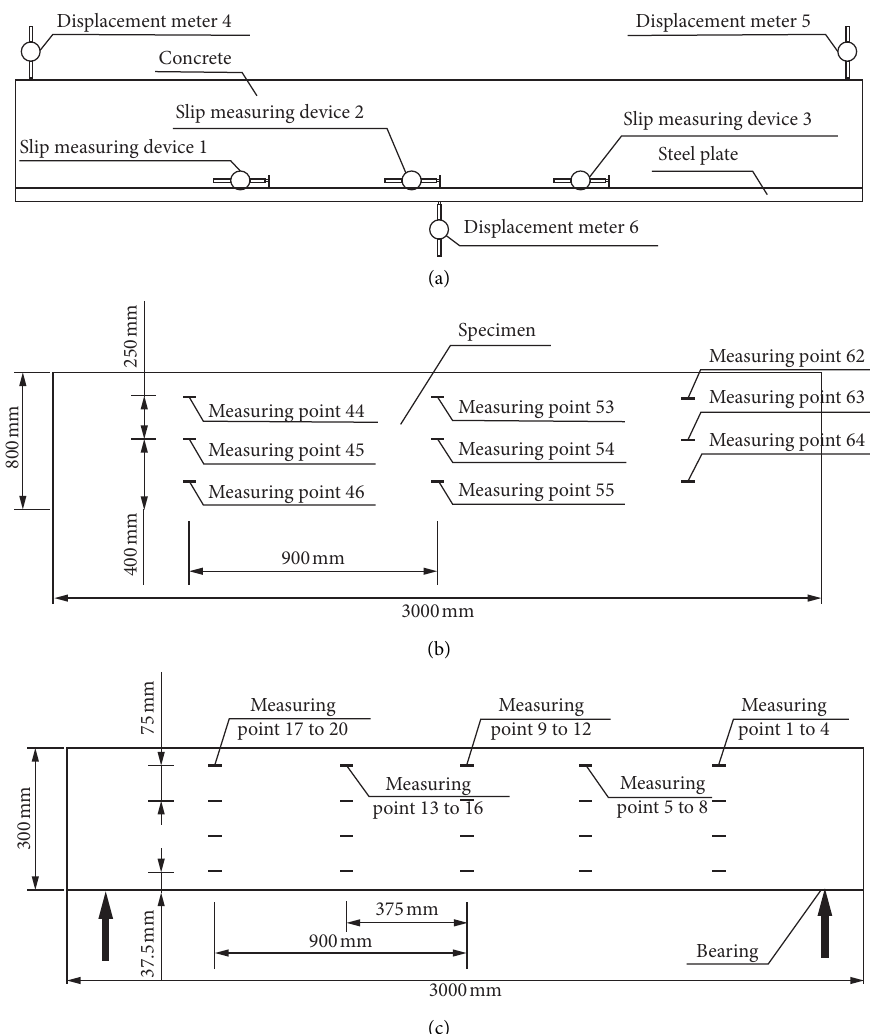
Figure 6: Point position map: (a) displacement meter layout, (b) arrangement of strain gauges, and (c) arrangement of strain